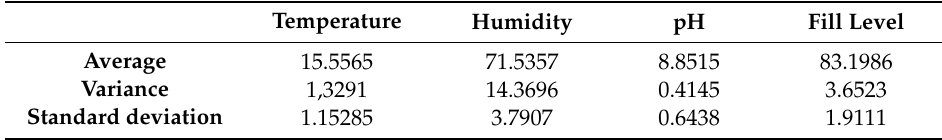
Table 6. Characterization of variables: Scenario 1 (00:00–12:00) 2 .